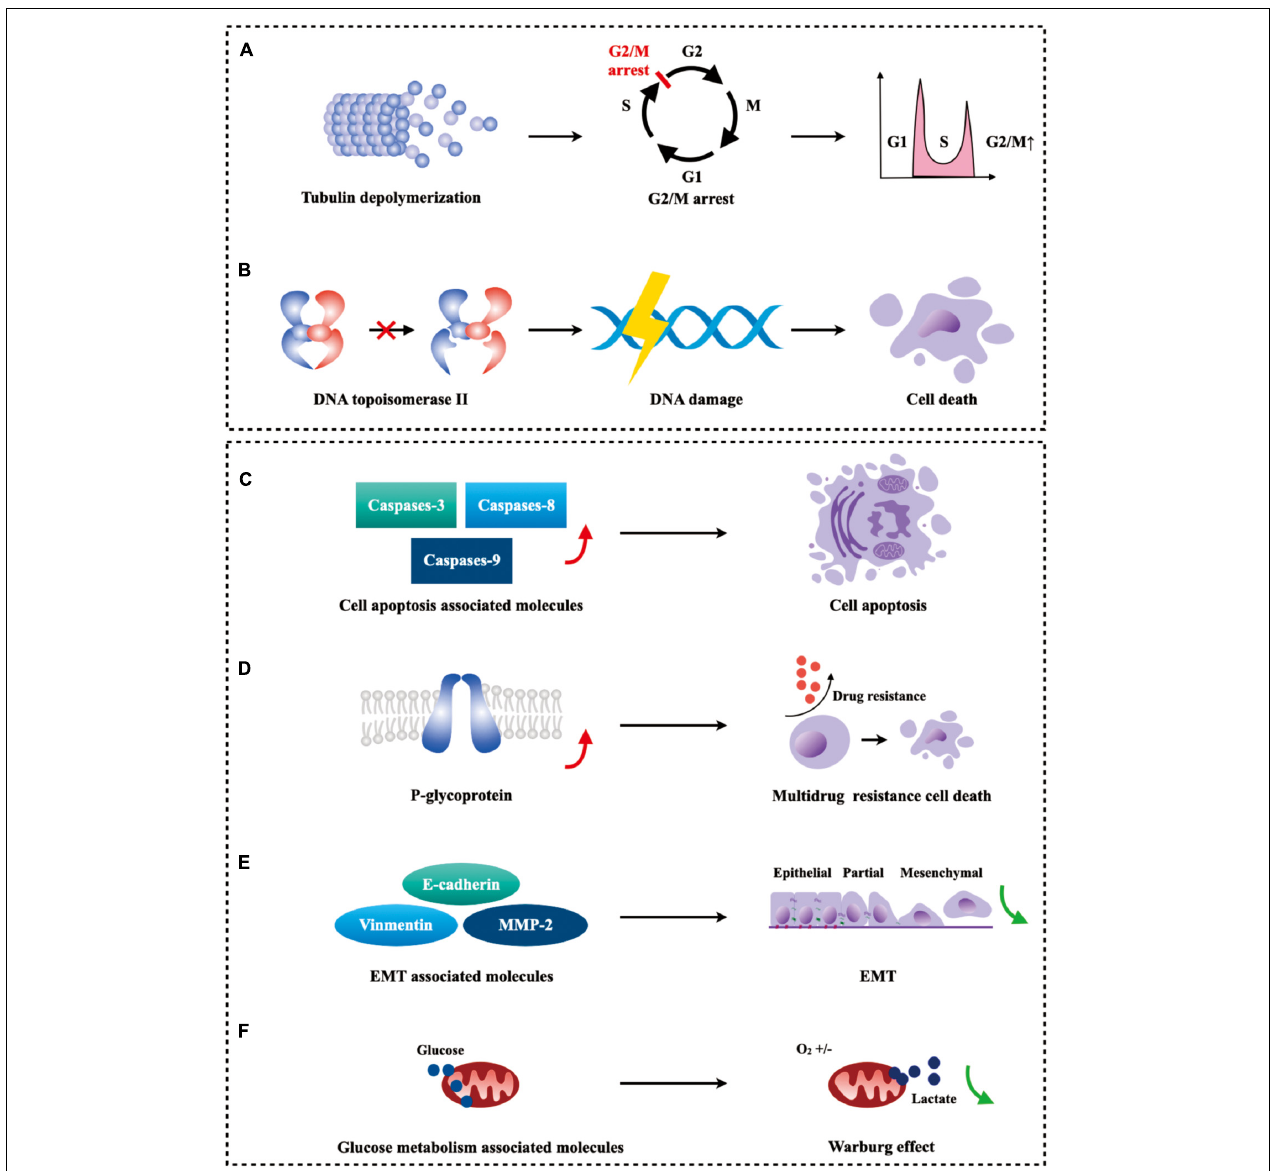
FIGURE 6 | Schematic diagram of the mechanism of PTOX derivatives for cancer treatment. (A) PTOX derivatives act as inhibitors of tubulin to induce G2/M arrest in tumor cells. (B) PTOX derivatives can inhibit the degradation of topoisomerase II to cause DNA damage and eventually trigger cell death. (C–F) PTOX derivatives can inhibit the growth of tumor cells by affecting drug-resistant tumor cells, apoptosis-related molecules, EMT-related molecules, and gluconeogenesis-related molecules,